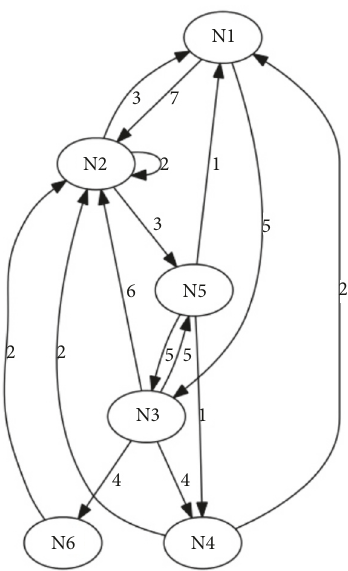
Figure 8: Graph configuration 26,940. Edge weights are shown next to the edges. Node 1 has weight 20, node 2 has weight 8, node 3 has weight 10, node 4 has weight 10, node 5 has weight 15, and node 6 has weight 4.